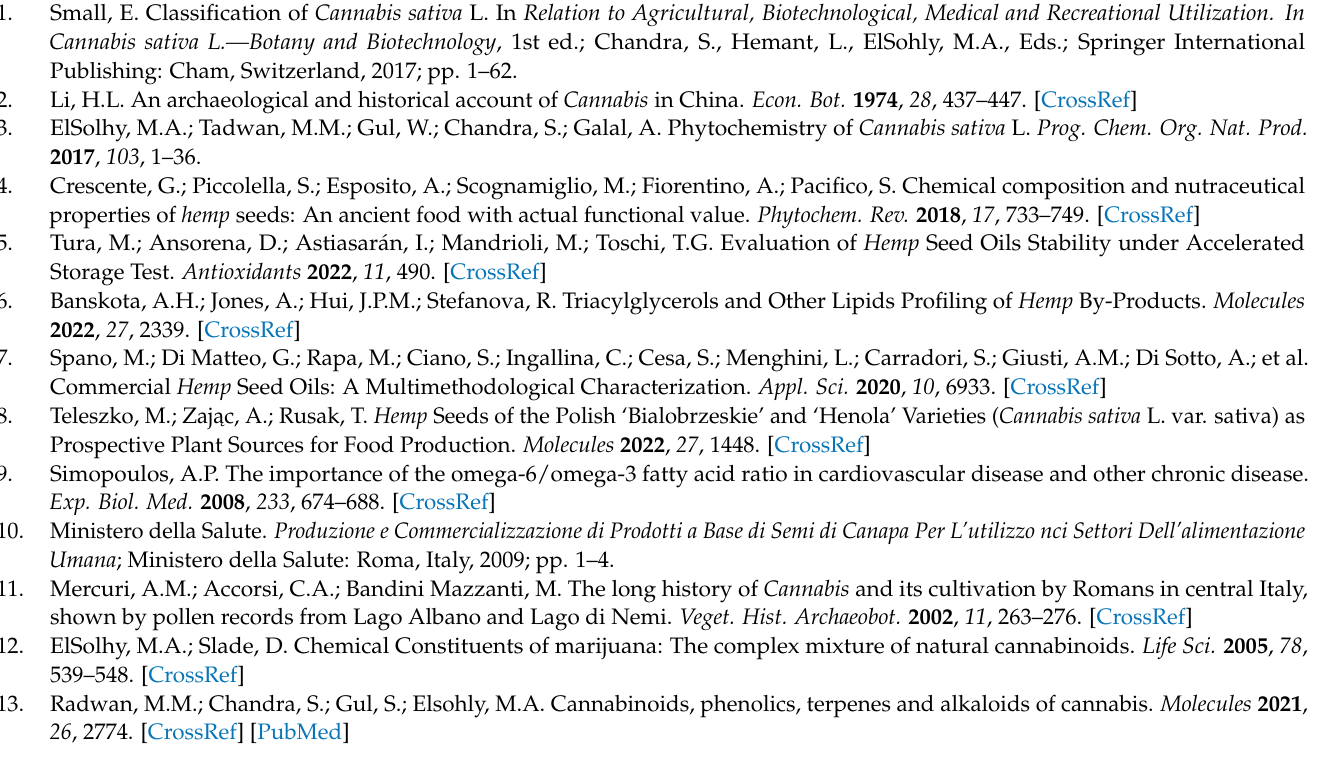
spectra ethanol (blue), acetone (red) and hexane (green) extracts for the Tiborszallasi variety; Figure S2: Comparison between 1 H NMR spectra of ethanol (blue), hexane (red) and acetone (green) extracts for the Kompolti variety; Figure S3: Comparison between the enlarged region [6.25 ppm–6.5ppm] of the 1 H NMR spectra from the hexane extract of the Tiborszallasi (blue) and Kompolti (purple) varieties. A broad peak isolated at 6.40 ppm corresponding to the proton H-10 of ∆ 9-THC appears in the proton spectra of Tiborszallasi, while this signal is undetectable in the 1 H NMR spectrum acquired for Kompolti; Figure S4: Biplot of PCA carried out on NMR spectra of acetone (red dots), hexane (blue dots) and ethanol (orange dots) extracts of the Kompolti variety of hemp. The score plot shows the first two PCs (PC1 and PC2) with their respective variations. R2X(PC1) = 51.8%, R2X(PC2) = 17.5%; Table S1: The 1 H NMR data of main cannabinoids in Kompolti